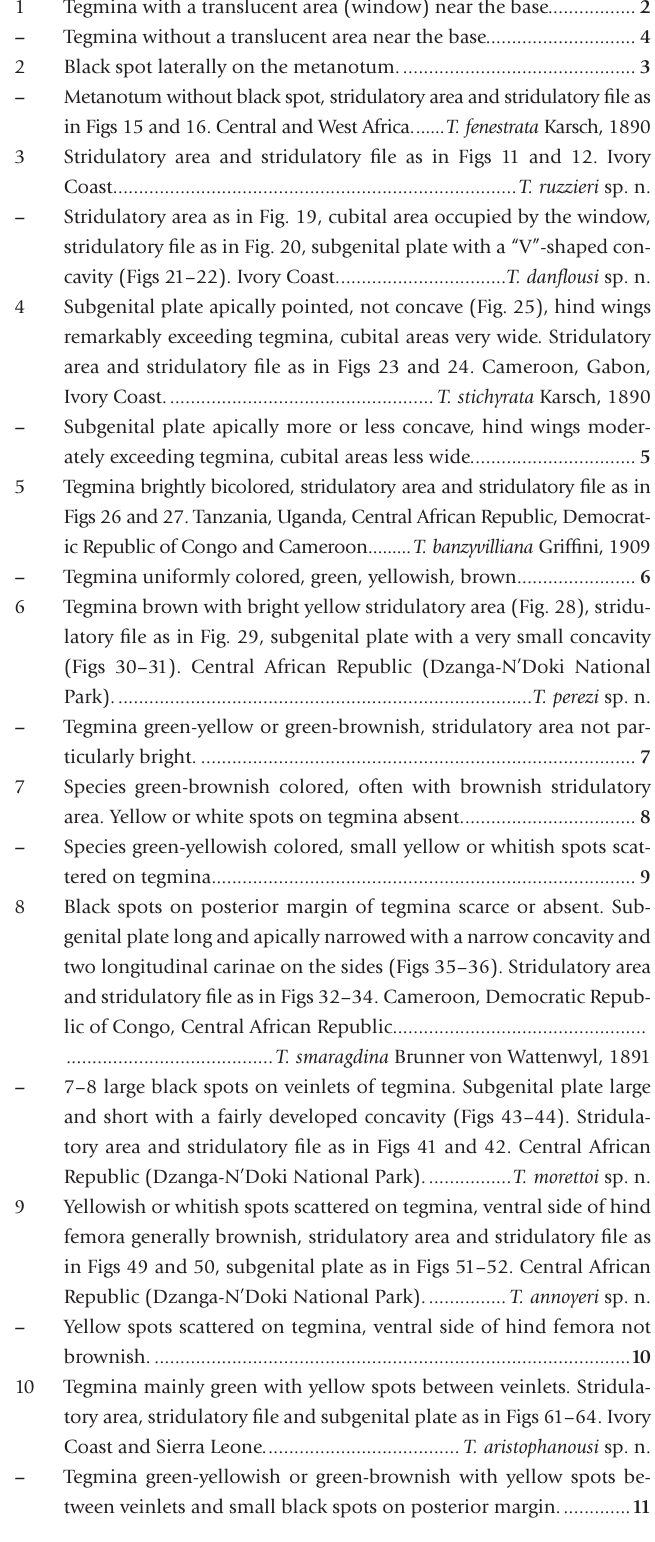
veinlets with small brownish spots in T. fenestrata and in T. aristopha- nousi sp. n., a net of veinlets with black spots in T. stichyrata , a very singular color in T. banzyvilliana , while in T. longipes the pattern of black spots in the tegmina is very similar to that of T. stichyrata . The genus Tetraconcha is known for its high sexual